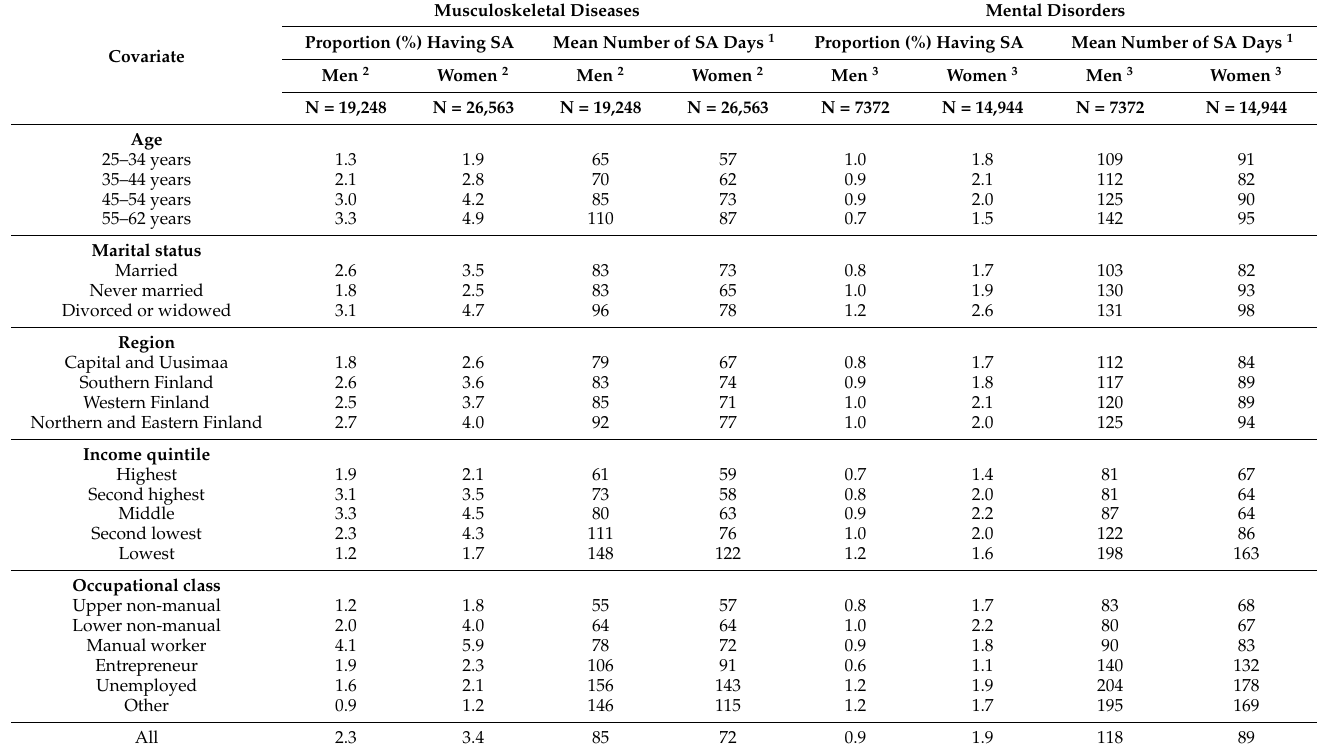
Table 2. Proportion of persons having sickness absence (SA) in 2013 and mean number of sickness absence days among person with sickness absence spells due to musculoskeletal diseases and mental disorders by covariates.